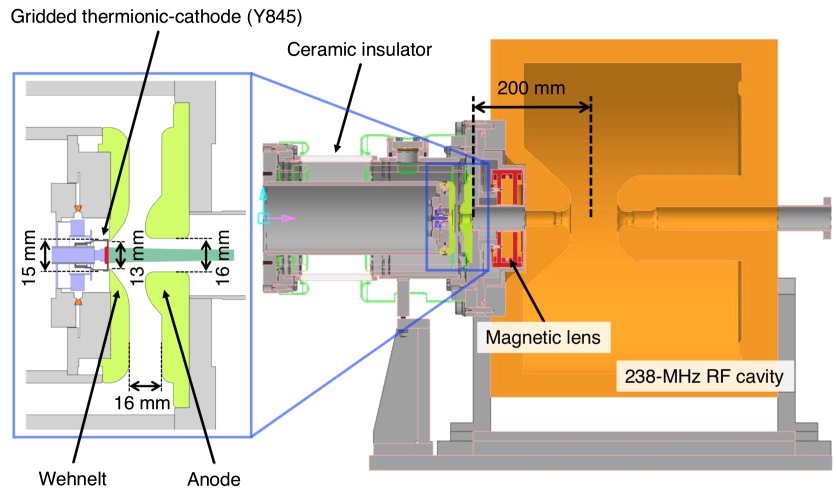
FIG. 3. Beam aperture, arrangement, and mechanical shape of each component along the rf gun system. The green belt in the inset represents the electron beam envelope simulated by CST